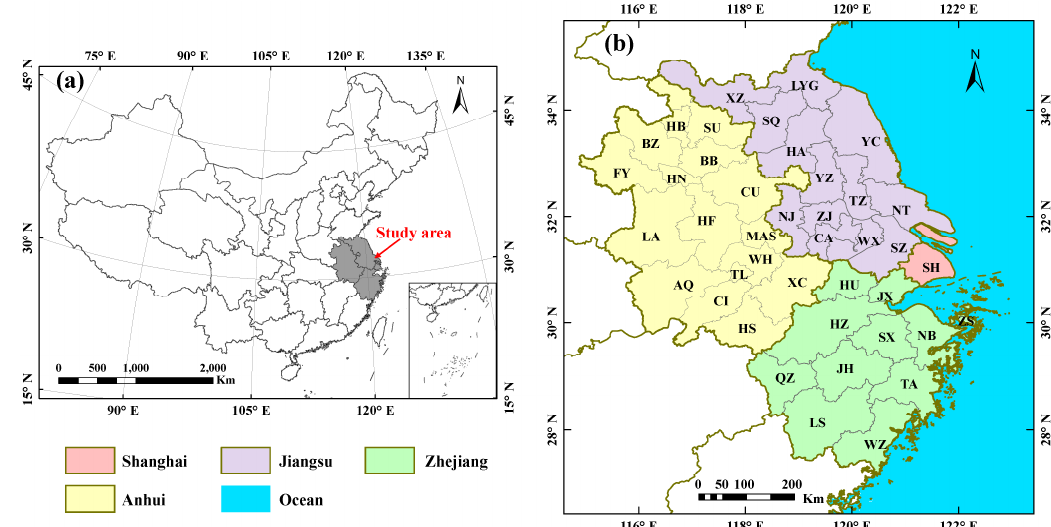
Figure 1. Study area: ( a ) location of the Yangtze River Delta (YRD) in China; ( b ) the 41 cities of the YRD (full names of the cities are listed in Table S1). The administrative boundary layer with a scale of 1:250,000 was obtained from the Data Center for Resources and Environmental Sciences, Chinese Academy of Sciences [51].